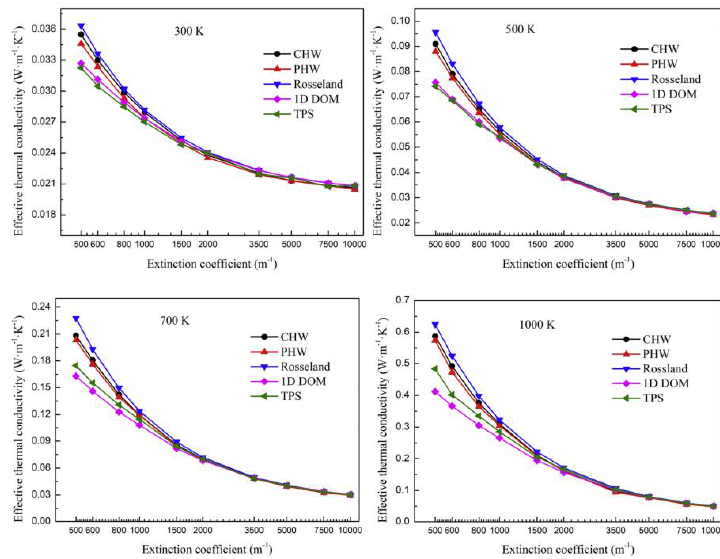
Figure 21. Influence of extinction coefficient.